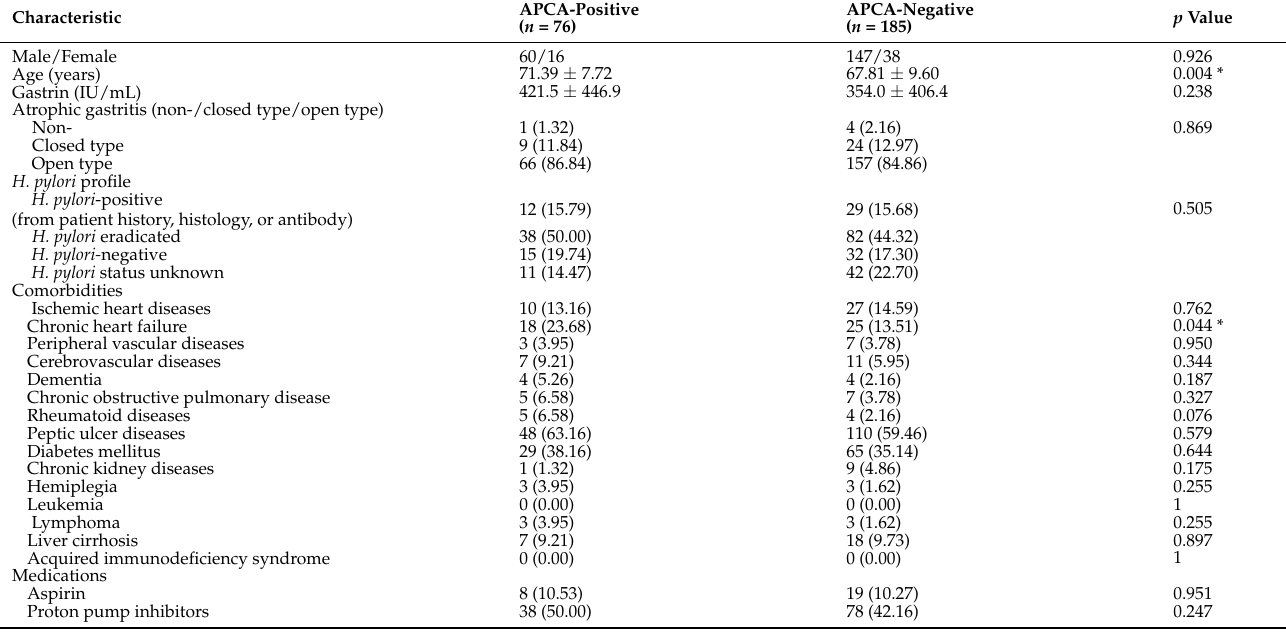
Table 1. Baseline patient